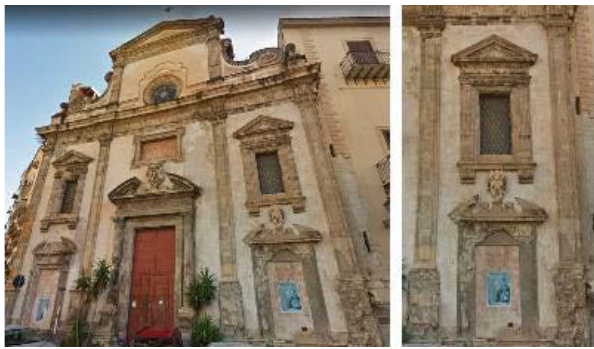
Figure 2. Church of San Sebastiano in Palermo (IT) - facade detail